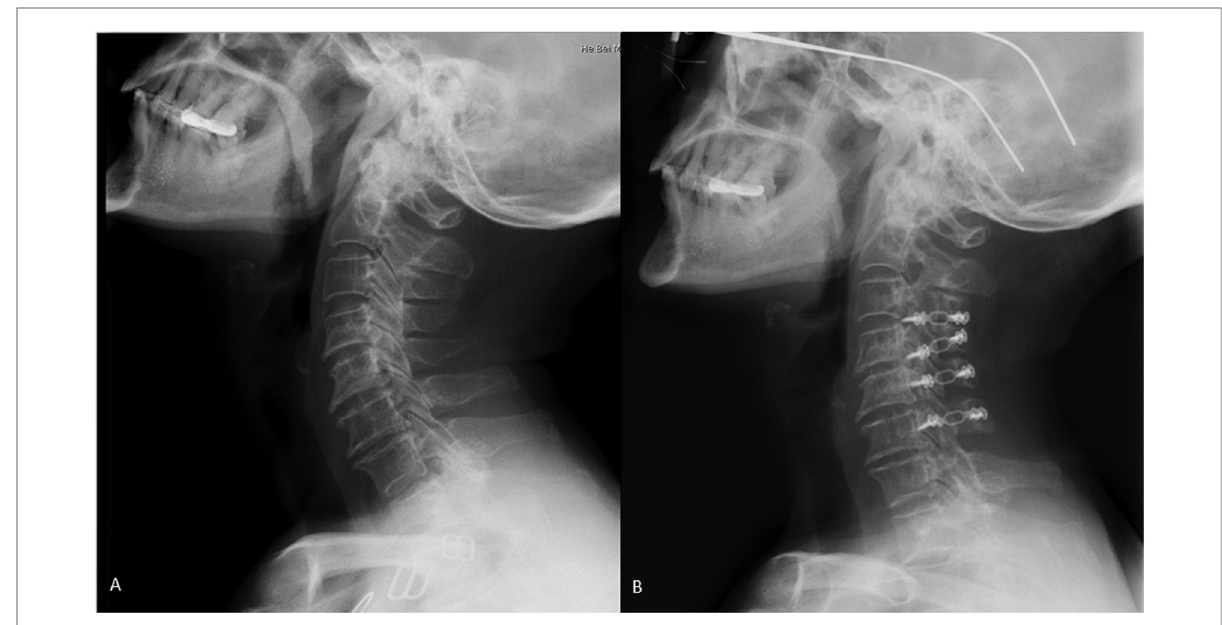
FIGURE 2 Posterior cervical surgery was performed to release the compression. Lateral x-ray of cervical spine was taken in a male patient with OPLL at preoperative and postoperative. A is preoperative, B is